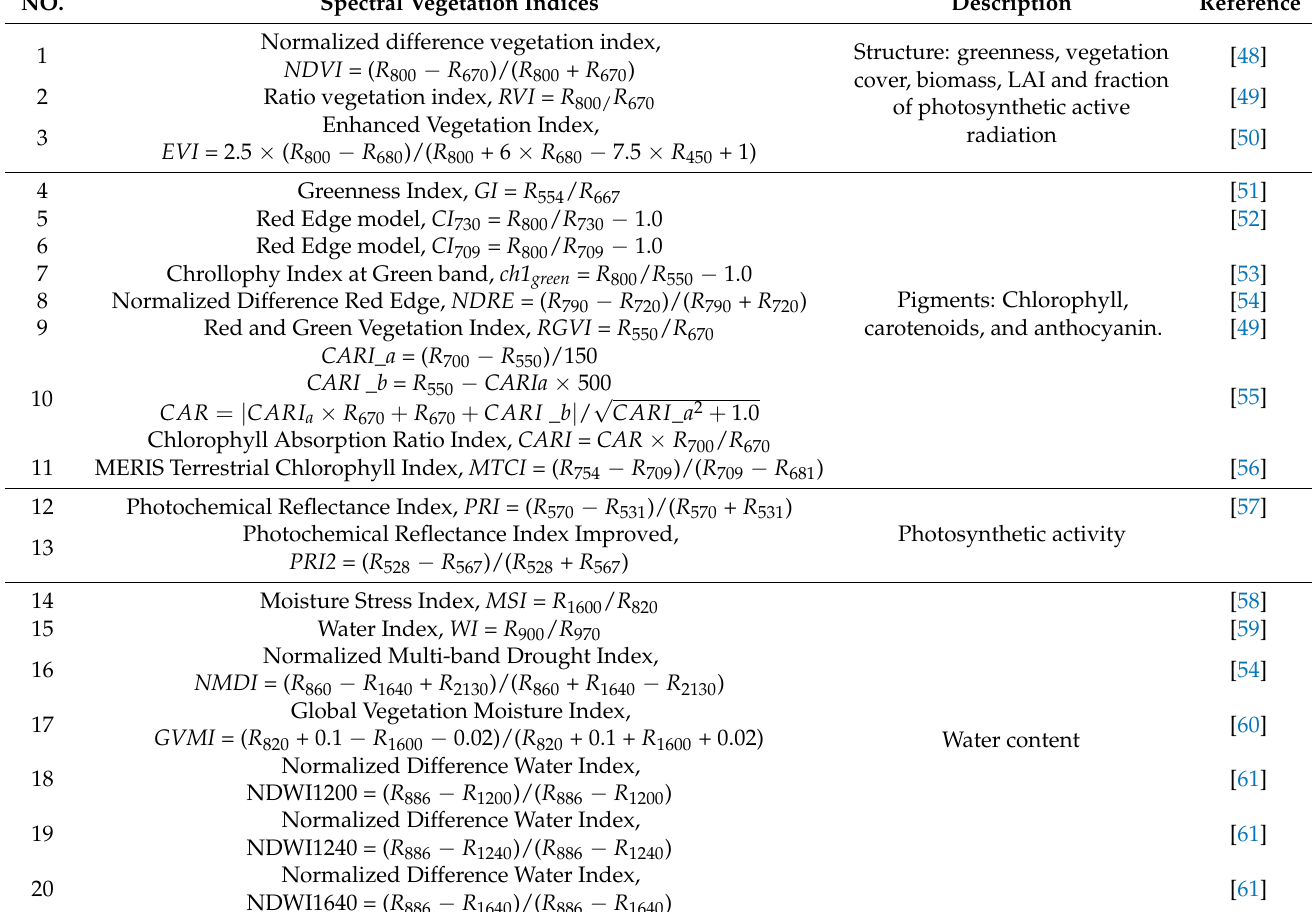
Table 1. The 20 selected spectral vegetation indices examined in this research, together with their band-specific formulations, and associated principal